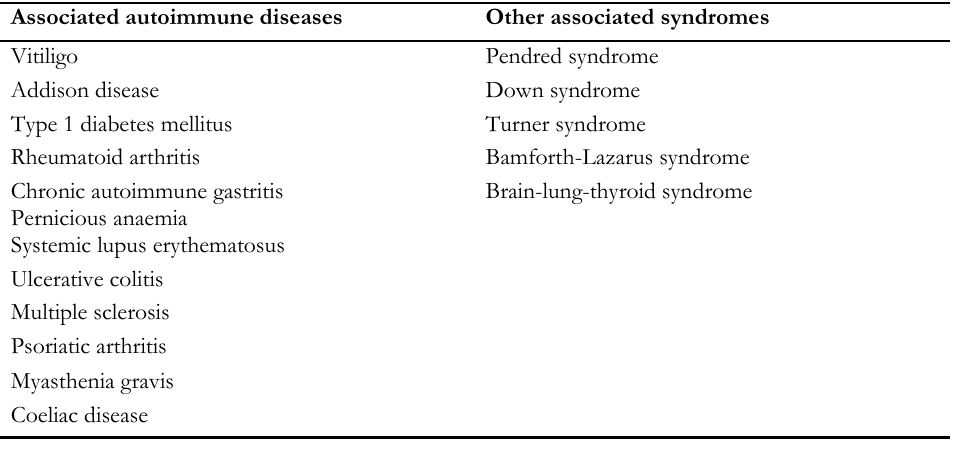
Table 2.3. Diseases and syndromes associated with hypothyroidism